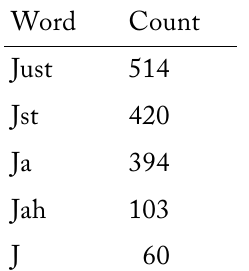
Table 3: Top five words containing